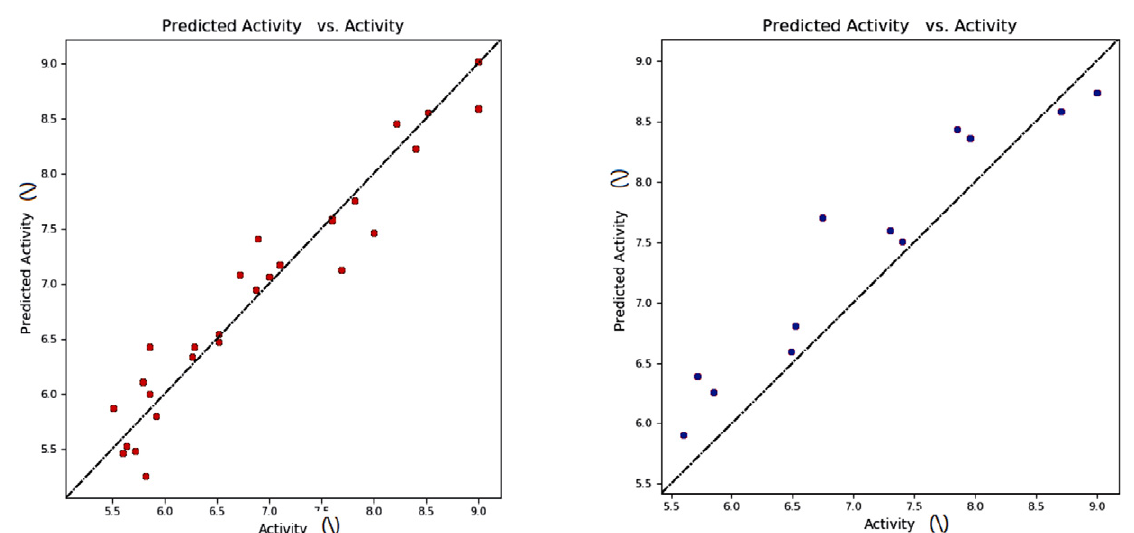
Fig. 3. The plot of the correlation between the experimental and predicted activity of based indolyl aryl sulfones inhibitors using pharmacoph- ore-based QSAR model of training and test